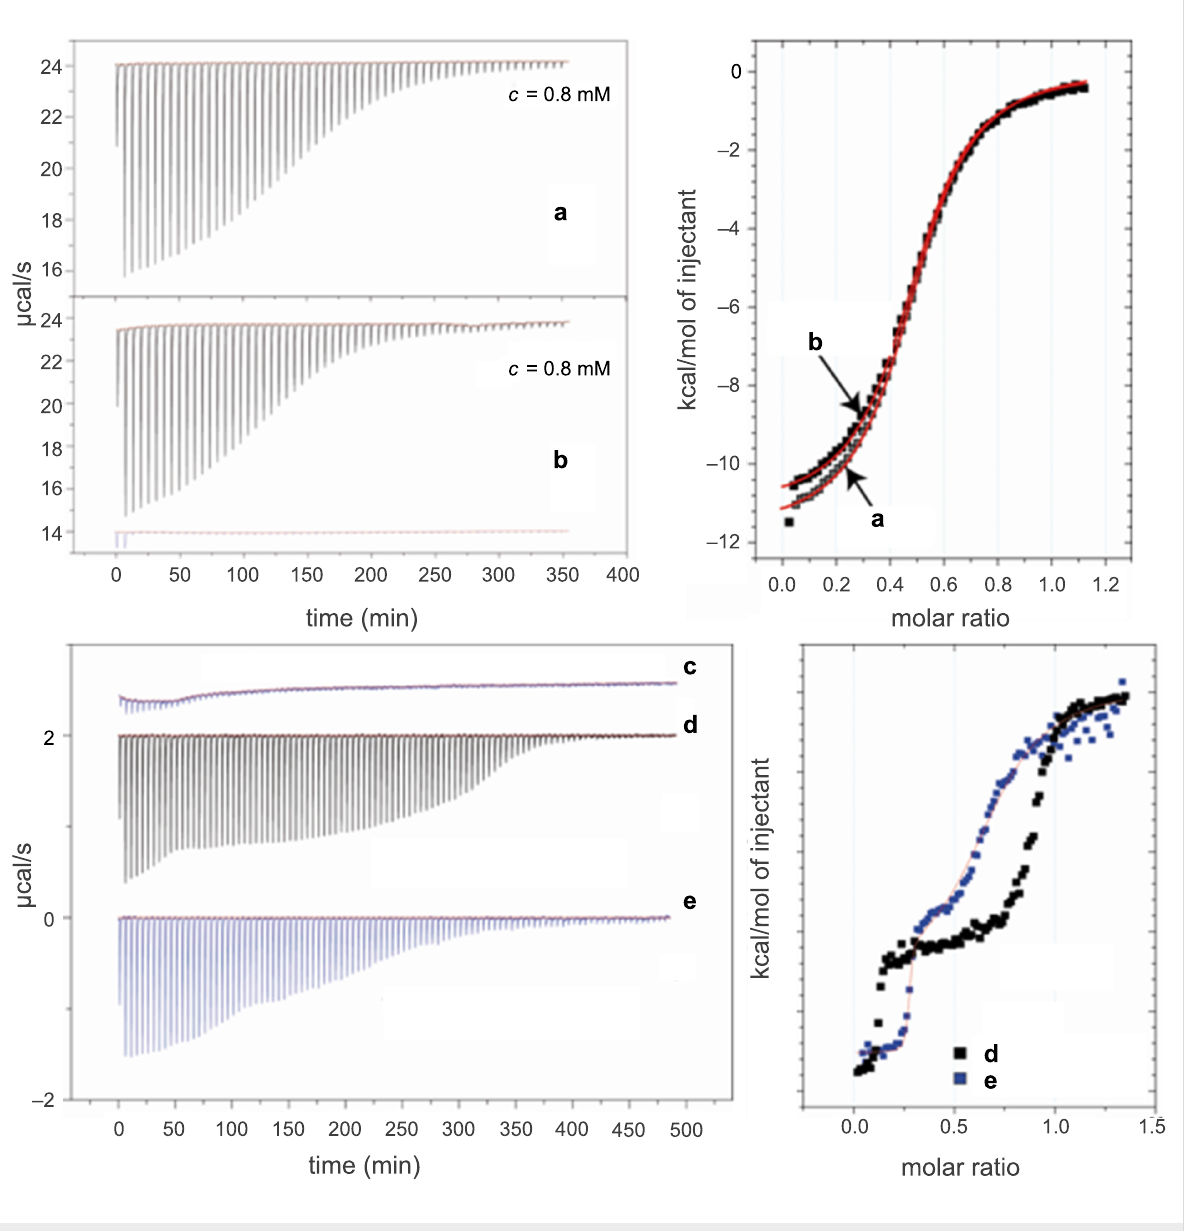
Figure 6: Titration of (a) β -CD ( c = 0.8 mM) and (b) β -CD-NH 2 ( c = 0.8 mM) by ADAdim 4 ( c = 4 mM). (c) Dilution of ADAdim 4 ( c = 0.6 mM) in water at 298 K. Titration of AZO-CDim 1 ( c = 0.1 mM) by ADAdim 4 ( c = 0.6 mM) (d) before irradiation at 298 K and (e) after irradiation in water at 365 nm for 120 min at 278